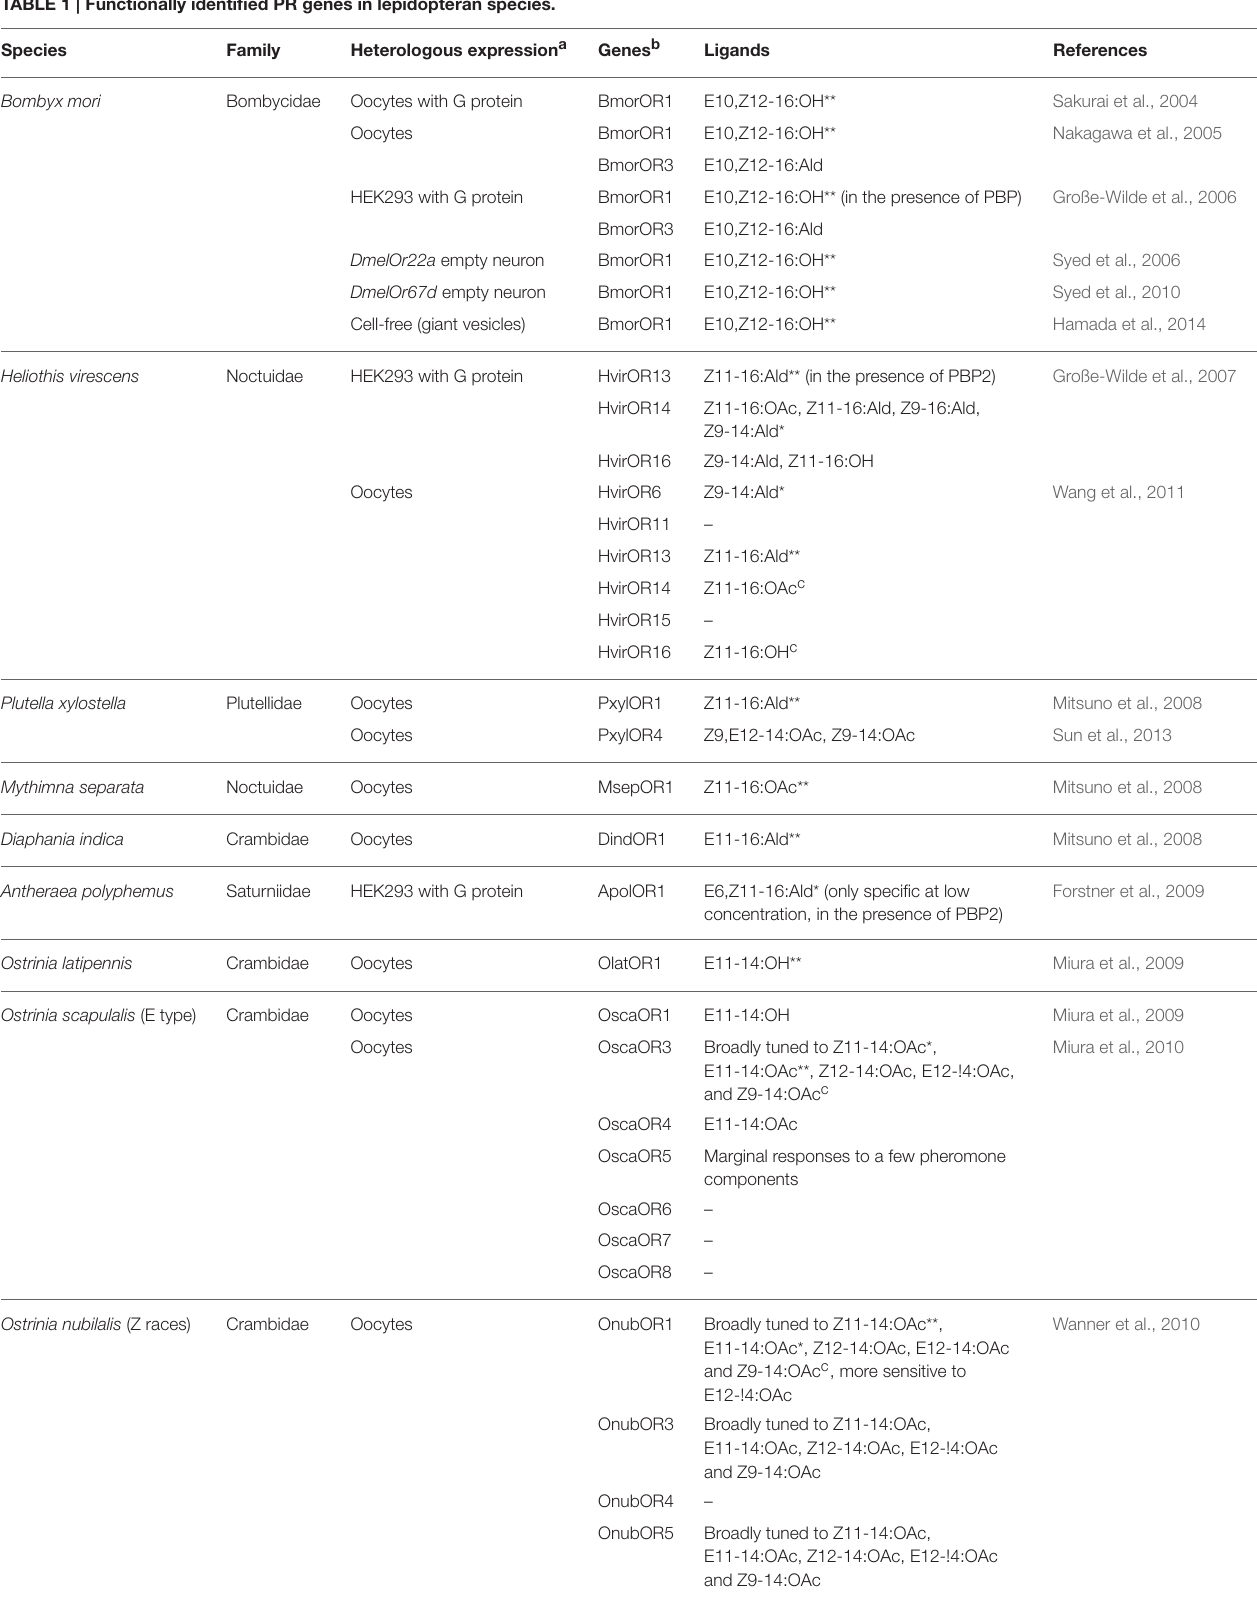
TABLE 1 | Functionally identified PR genes in lepidopteran